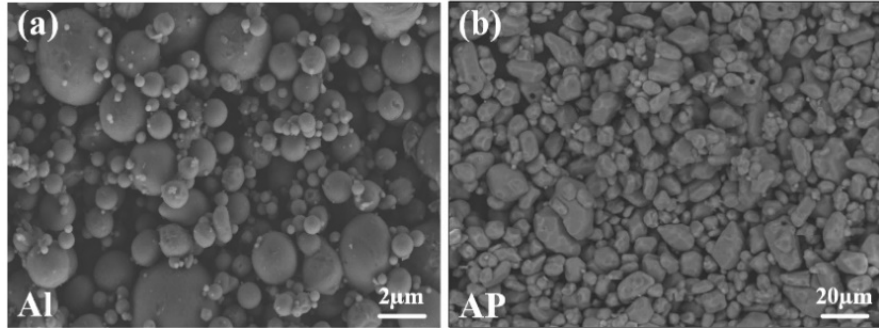
Figure 1. SEM of modified Al ( a ) and ultra-fine AP ( b ).